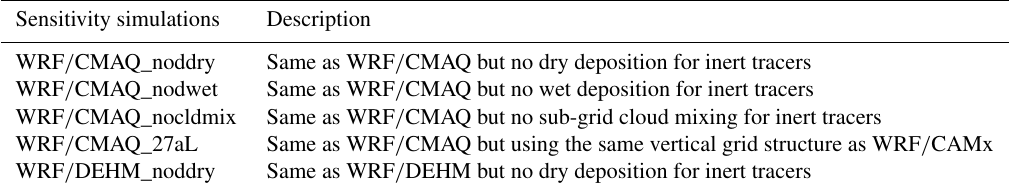
Table 2. Description of the sensitivity simulations. Sensitivity simulations